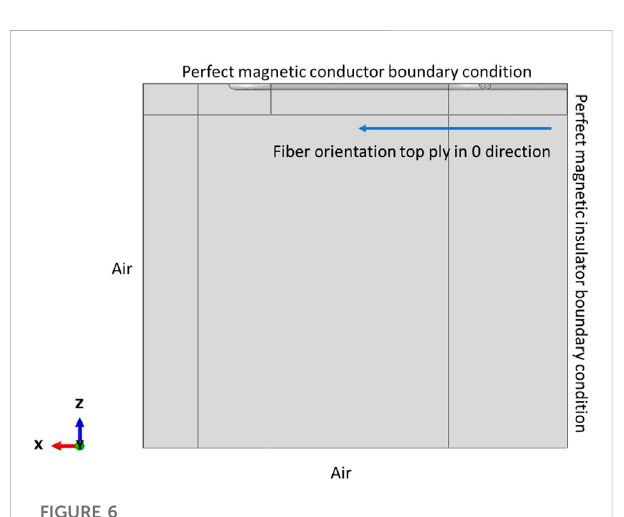
FIGURE 7 Convection coef fi cients used on the top and bottom surface of the plate and the external sides exposed to the surrounding Because the laminates considered in this work have a ply orientation of 0 ° or 90 ° these symmetry conditions can also be applied to the composite laminate. Furthermore, surrounding the coil and laminate a box of air is modelled with dimensions 400 × 400 × 500 mm. The external surfaces of this box of air are assumed magnetic insulators: